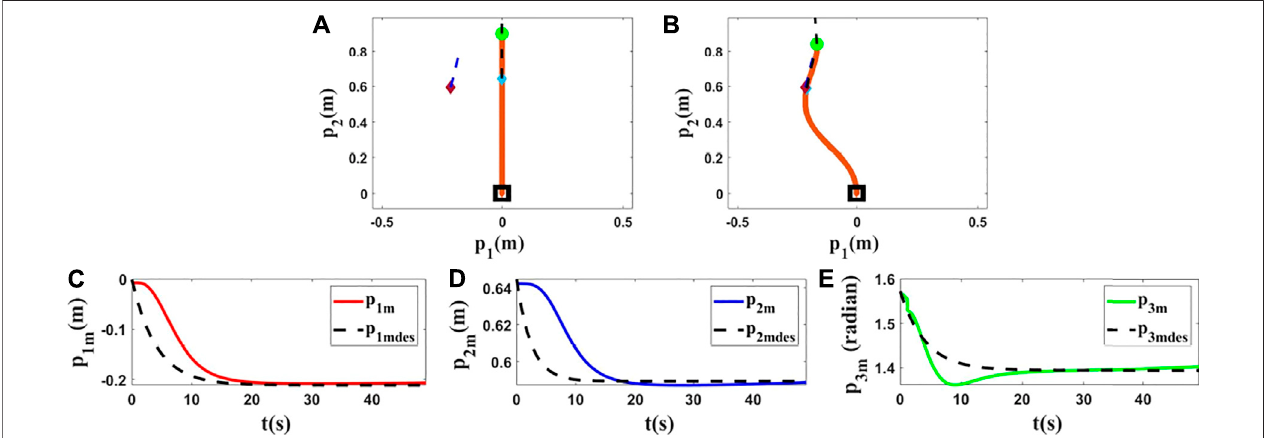
FIGURE 5 | Simulation 3. First row: (A) and (B) are the initial and fi nal shape of the object, respectively. The desired state of the point m is shown as a purple diamond (position) and a dashed line segment (orientation). L is 0.90( m ), M 0 = [0.0000, 0.6430, 1.5708] T , and M fdes = [ − 0.2110, 0.5896, 1.3948] T . After applying the proposed controller, the fi nal state of M is M f = [ − 0.2089, 0.5891, 1.4010] T . Second row: (C) , (D) and (E) are the states of the controlled point regarding to the desired trajectories in the third simulation using the Kirchhoff model.